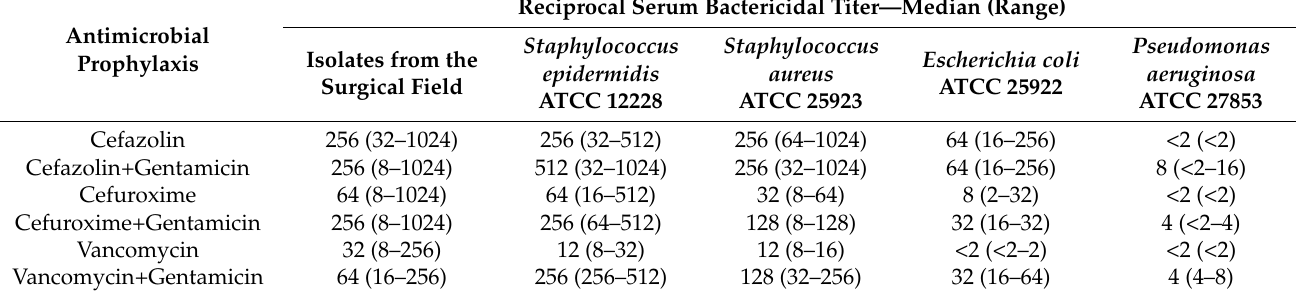
Figure 1. Reciprocal serum bactericidal titers against bacteria isolated in the surgical field for each surgical antimicrobial prophylaxis regimen. * Outliers are marked with an asterisk (*); outlier is defined as a data point that is located outside 1.5 times the interquartile range above the upper quartile and bellow the lower quartile. Table 4. Reciprocal serum bactericidal titers against bacteria isolated in the surgical field and reference strains for each antimicrobial prophylaxis.